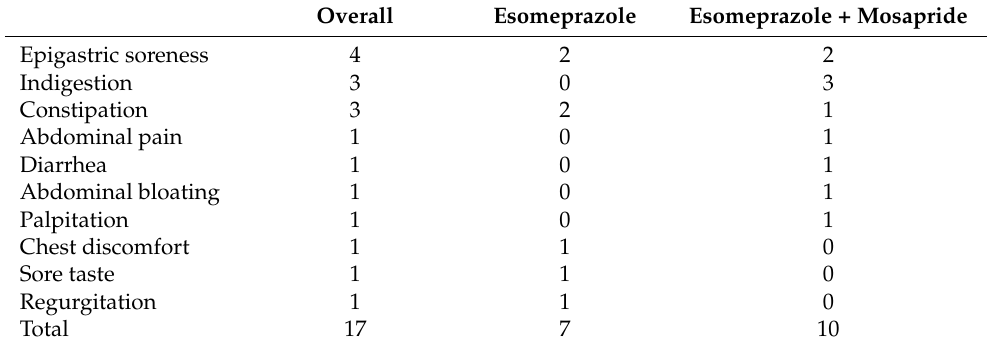
Table 5. Incidence of adverse drug reactions of the two